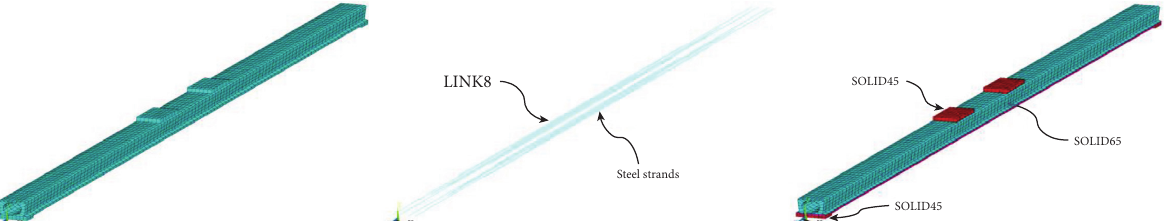
Figure 7: Finite element